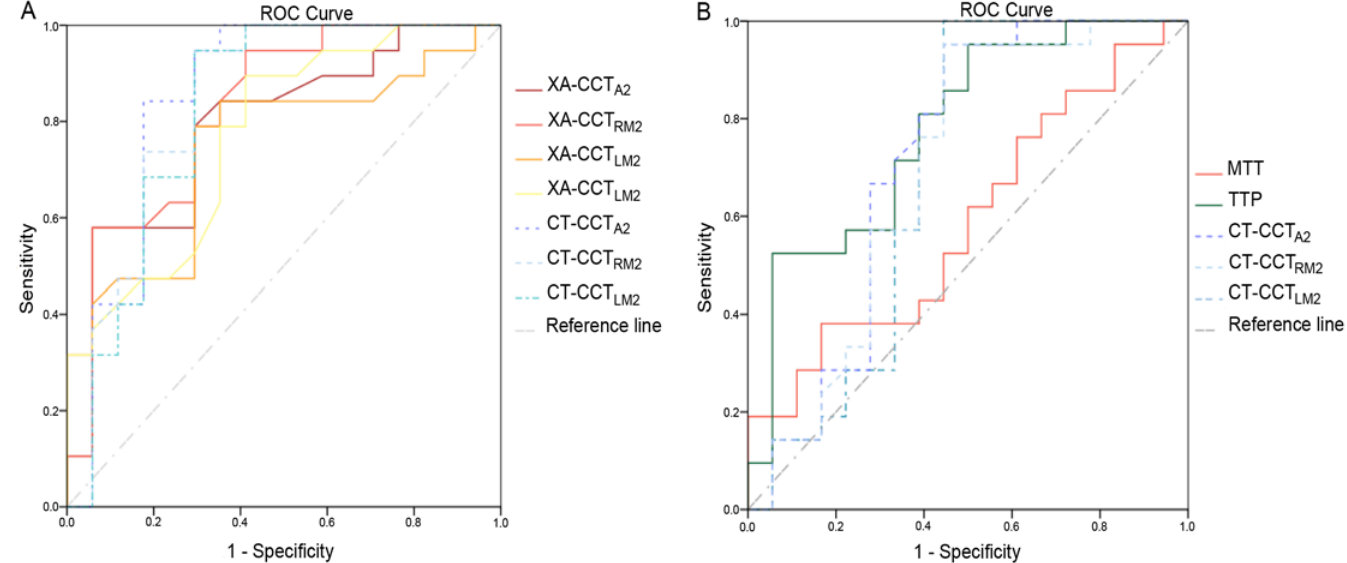
Fig 6. Receiver operating characteristic analysis. (A) Receiver operating characteristic analysis of all XA-CCTs and CT-CCTs. (B) Receiver operation characteristics analysis of all CT-CCTs, MTT and TTP